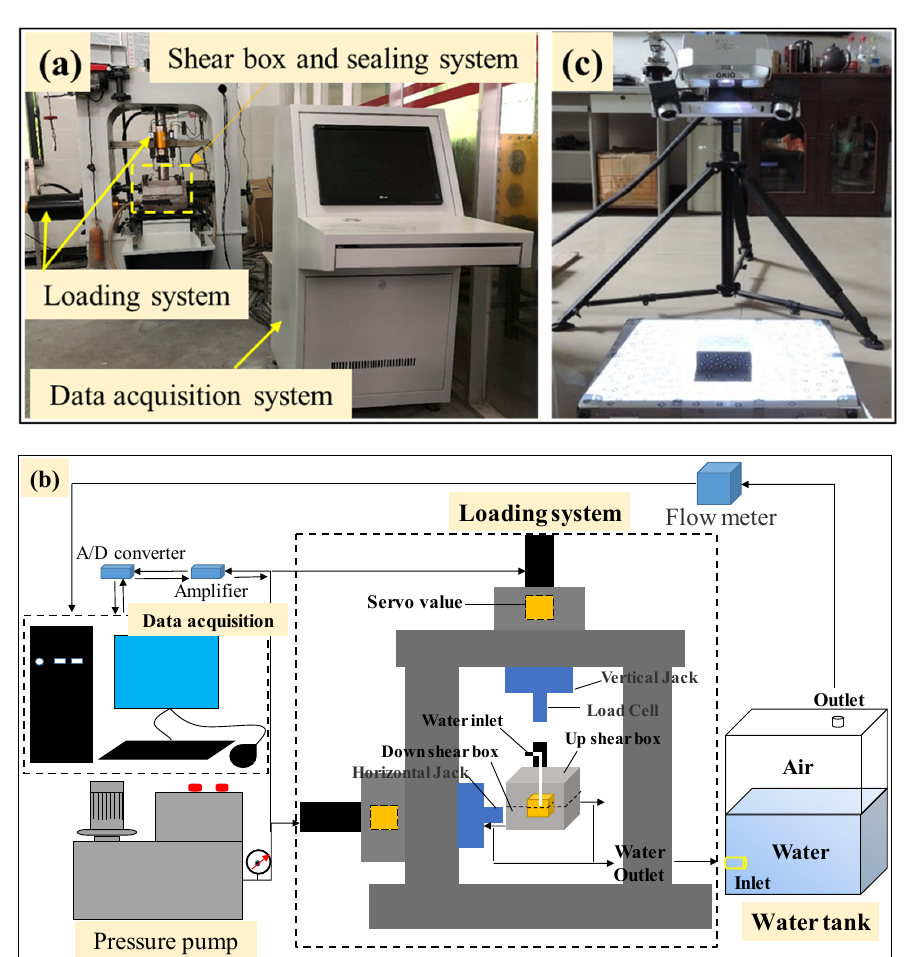
Figure 2. ( a ) Coal and rock shear–seepage coupling test system, ( b ) schematic of the shear–seepage system, and ( c ) 3D scanner.